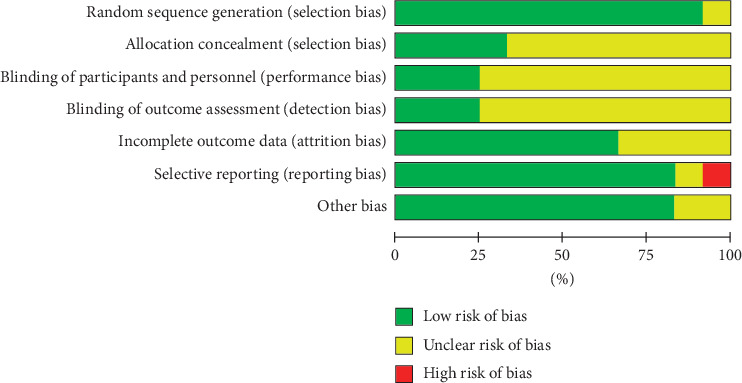
Risk of bias graph.